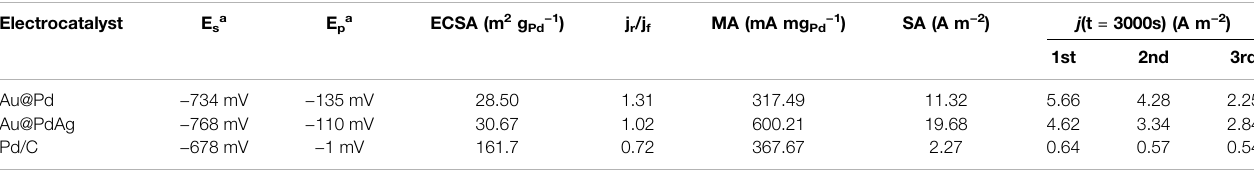
TABLE 2 | Summary of EOR performance of electrocatalysts in the present study.